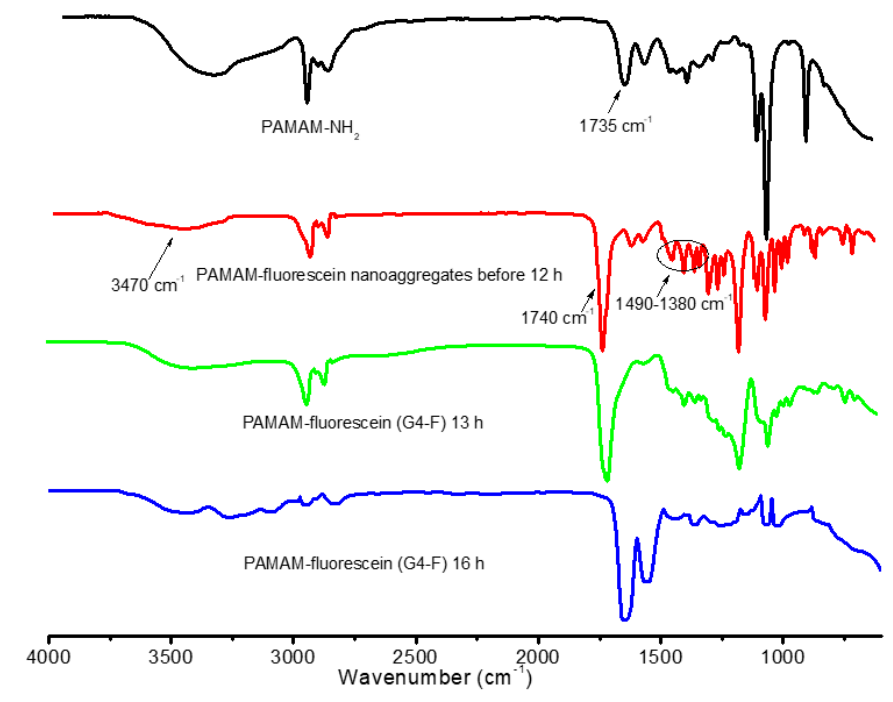
Figure 4. FT-IR spectra of unmodified PAMAM and G4-F nanoaggregate samples after different irradiation times.